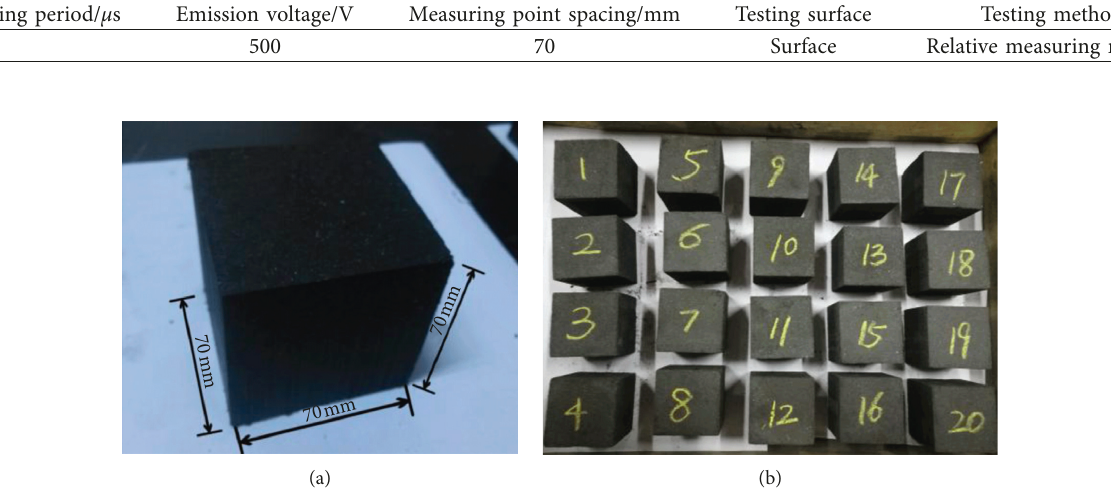
Table 3: Setting of system parameters of ultrasonic devices.